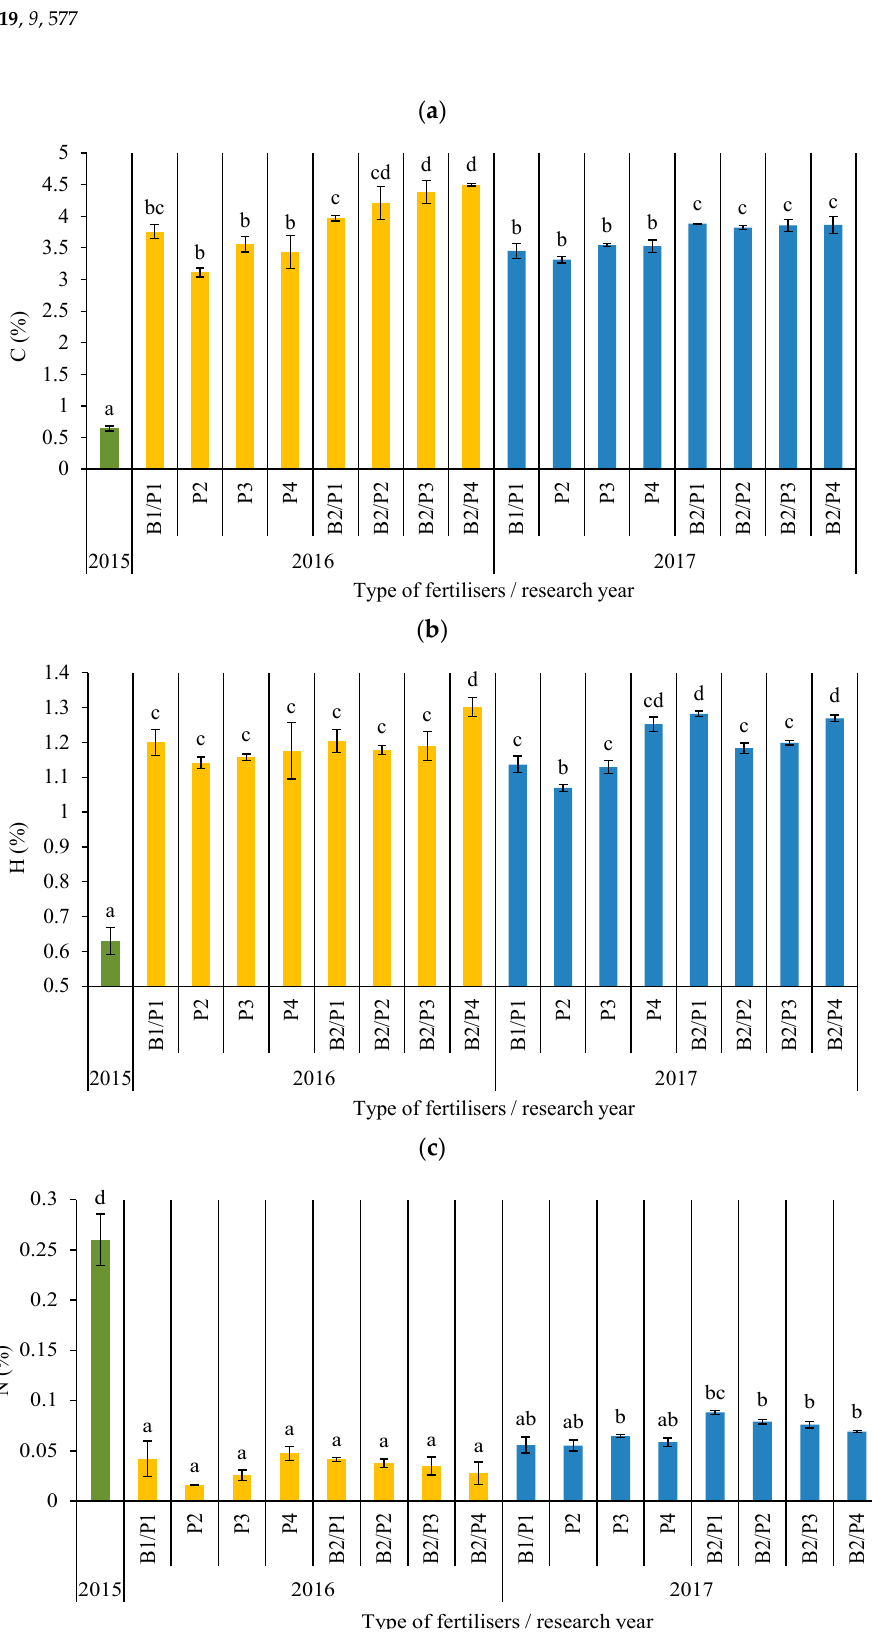
Figure 3. Contents of carbon ( a ), hydrogen ( b ) and nitrogen ( c ) in the soil prior to the experiment (2015) as well as following the first and the second year of cultivation in relation to the fertilisers applied. The mean values marked with the same letter do not differ significantly at a level of α ≤ 0.05 based on the results of the Bonferroni test.